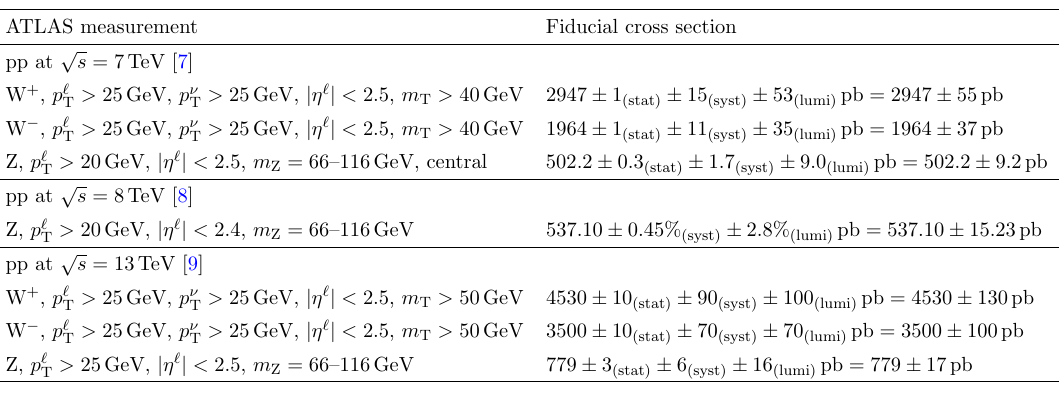
Table 1 . Compilation of the seven ATLAS measurements of inclusive W (cid:6) and Z boson production p cross sections in pp collisions at s = 7, 8, 13 TeV [7{9], used in this analysis. The three sources of experimental uncertainties, and the (cid:12)ducial selection criteria on the lepton transverse momentum ( p ‘;(cid:23) ) and pseudorapidity ( (cid:17) ‘ ), and (transverse) mass windows ( m T ) m Z are indicated. T LHCb measurement Fiducial cross section